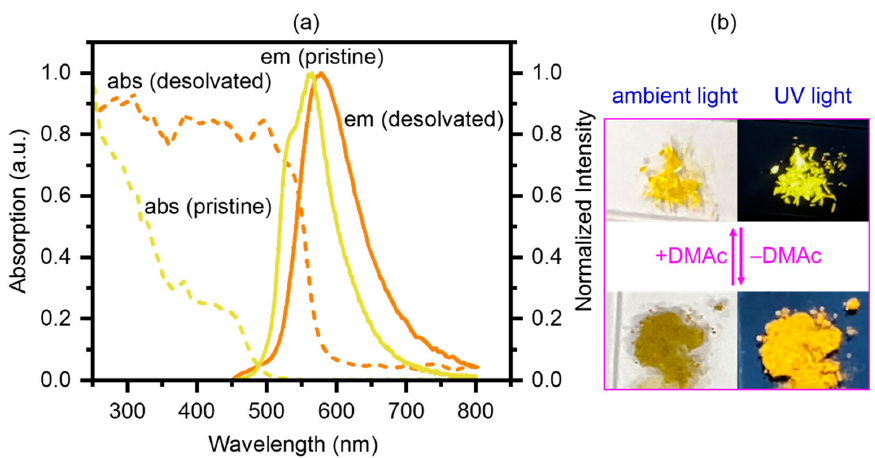
Figure 4. ( a ) The normalized UV-Vis absorption (dash) and emission (solid) spectra of Au 4 Cu 2 cluster before (yellow) and after removal of solvate DMAc (orange). ( b ) The images of Au 4 Cu 2 cluster complex under ambient light and UV light irradiation (365 nm) before and after desolvation.